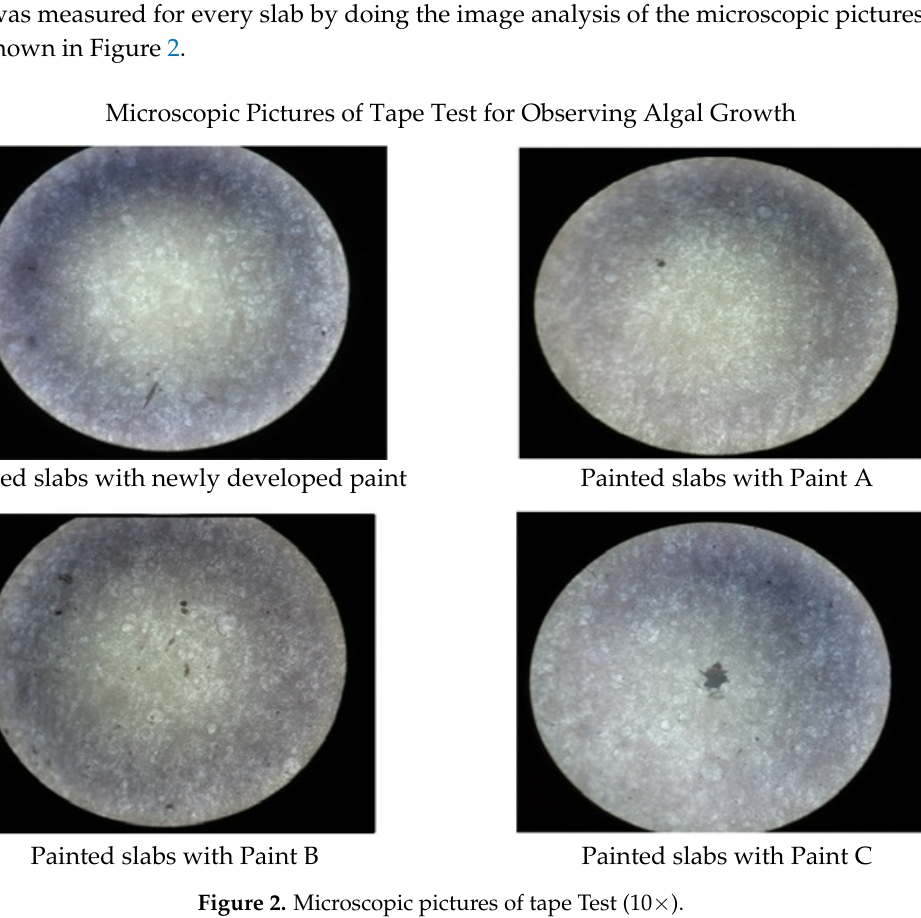
Figure 2. Microscopic pictures of tape Test (10×).